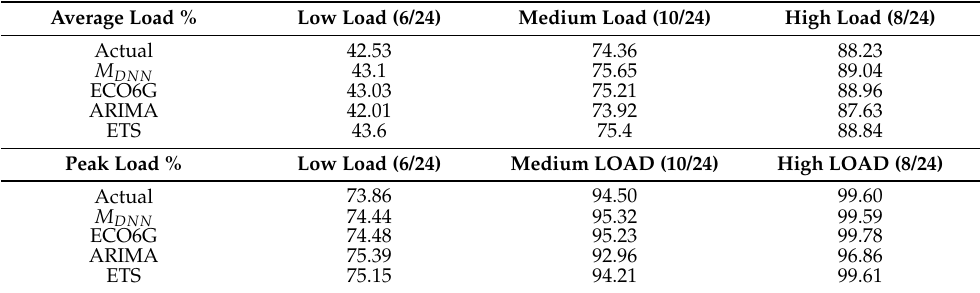
Table 2. Simulation results of average and peak load across all